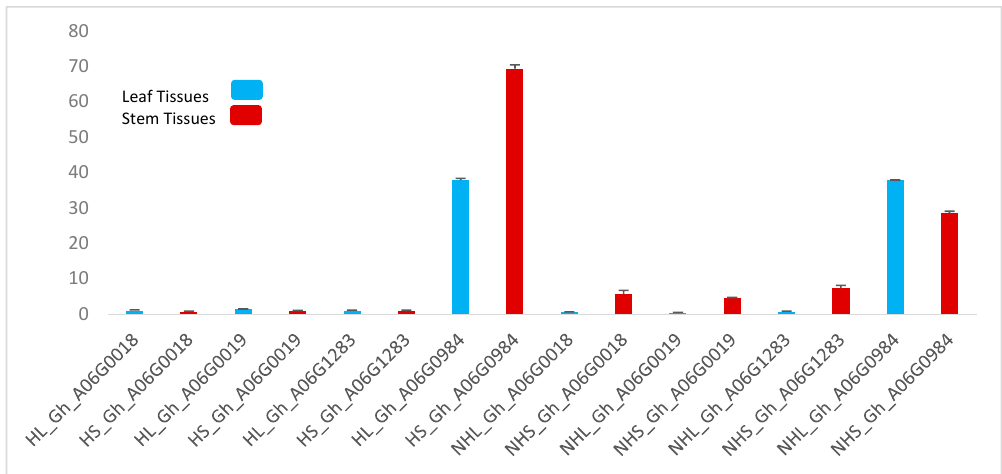
Figure 4. The gene expression profiles of four genes related to trichome formation. Two-color schemes showing leaf and stem tissues. HL: hairy leaf, HS: hairy stem, NHL: non-hairy leaf, NHS, non-hairy stem. Data represent the mean ± SD from three biological replicates.